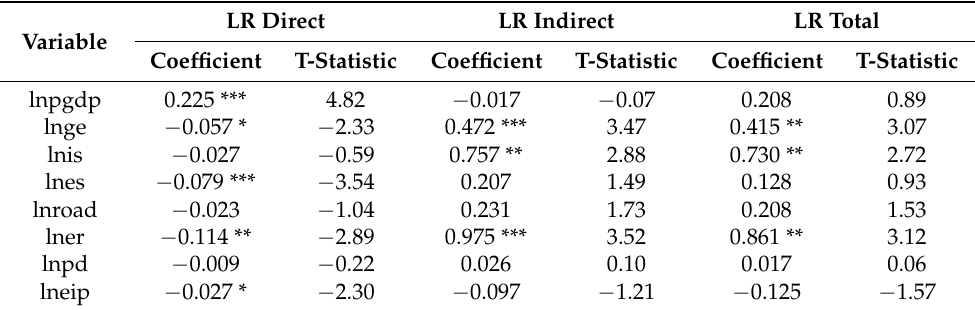
Table 7. Robustness test results after independent variable replacement.